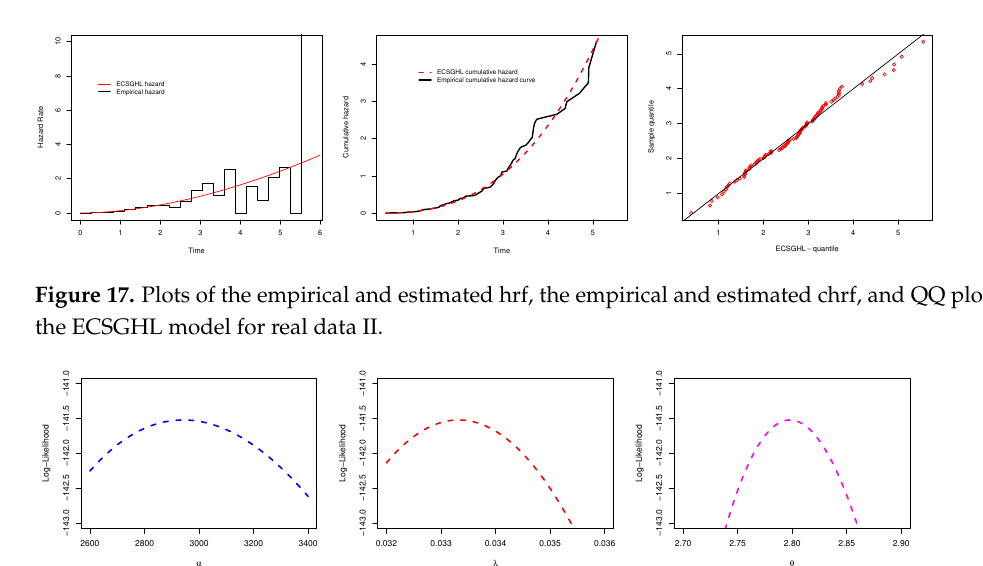
Figure 16. Plots of the histogram with the estimated pdf, and the empirical cdf with the estimated cdf of the ECSGHL model for real data II.